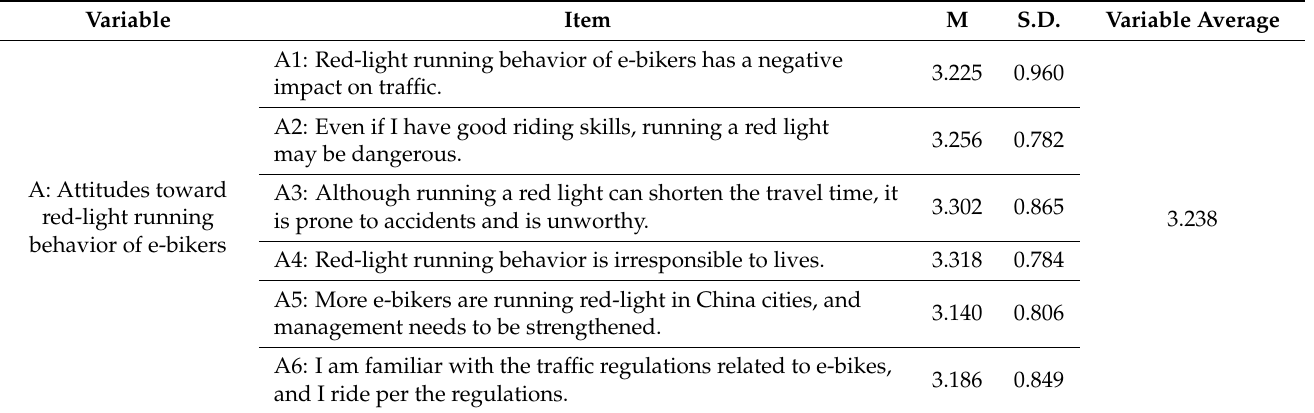
Table 4. The average and standard deviation of each item in the public questionnaire, n =